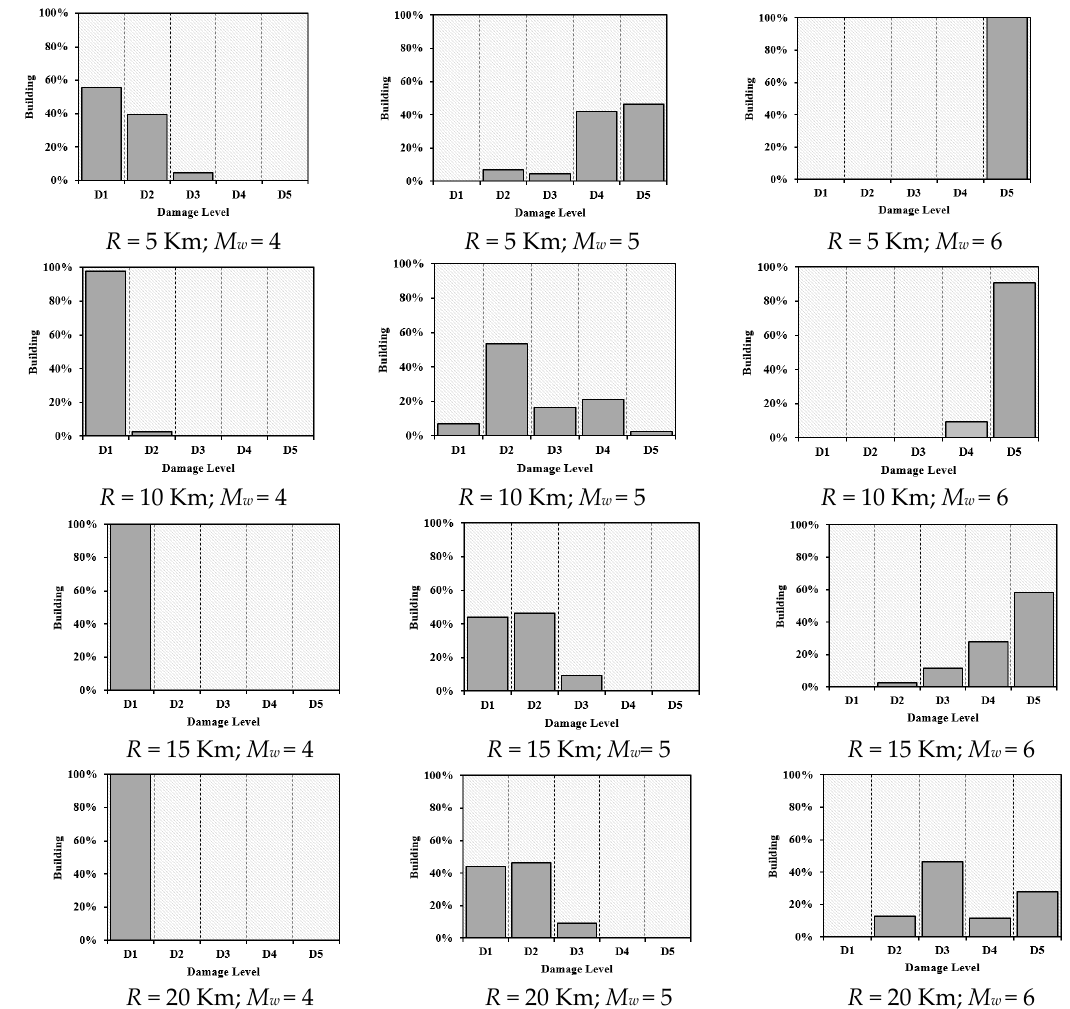
Figure 14. The damage distribution considering local seismic amplification effects.